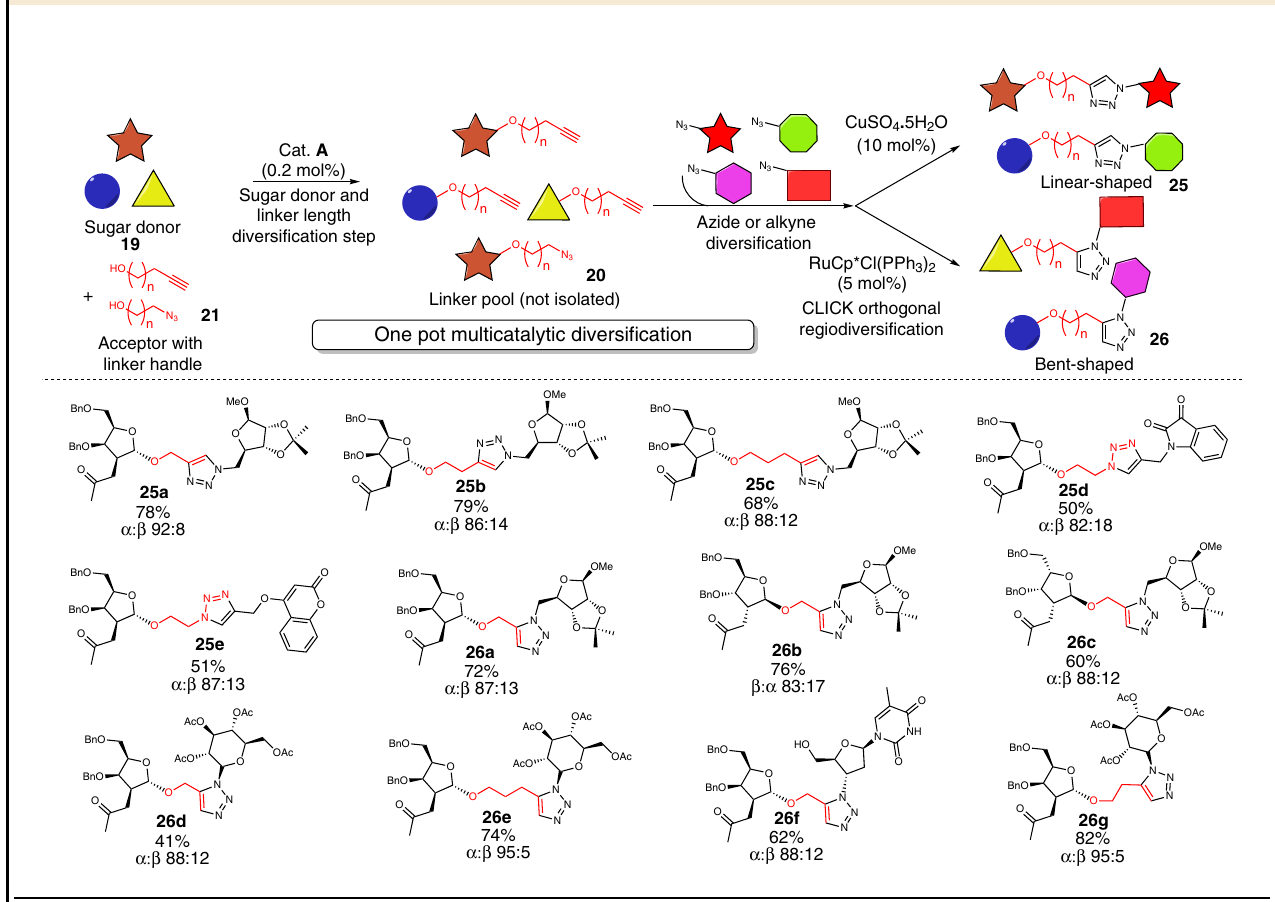
Table 5 Scope of one-pot multicatalytic diversi fi